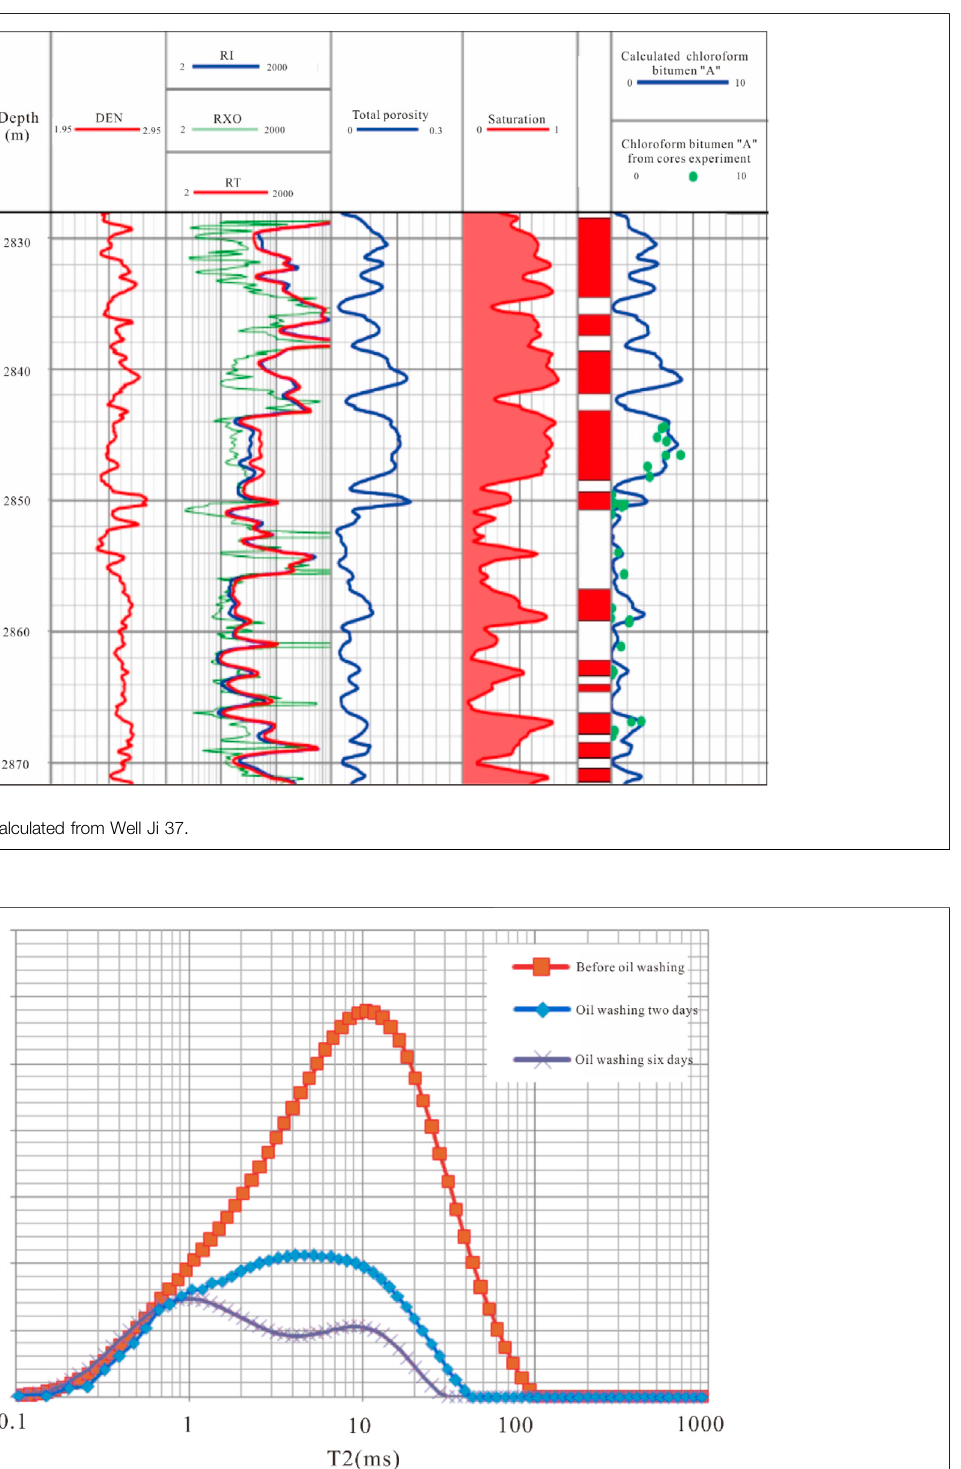
Frontiers in Earth Science |